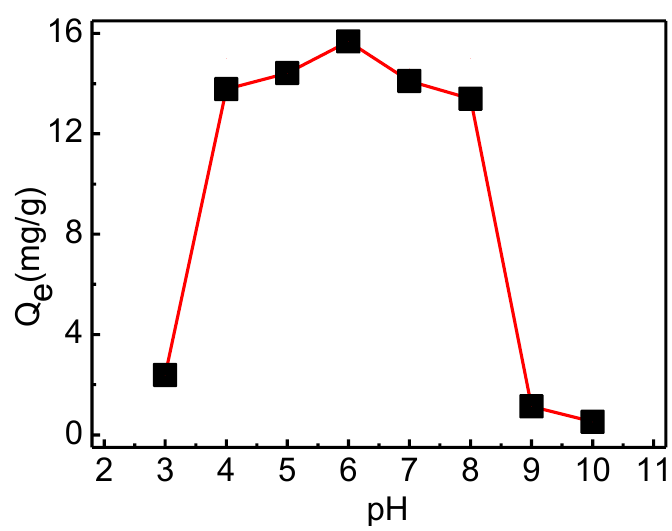
Figure 6. E ff ect of pH on phosphate adsorption by QCLF adsorbents (initial phosphate concentration 20 mg / L, volume 50 mL, mass 0.05 g, adsorption time 24 h).